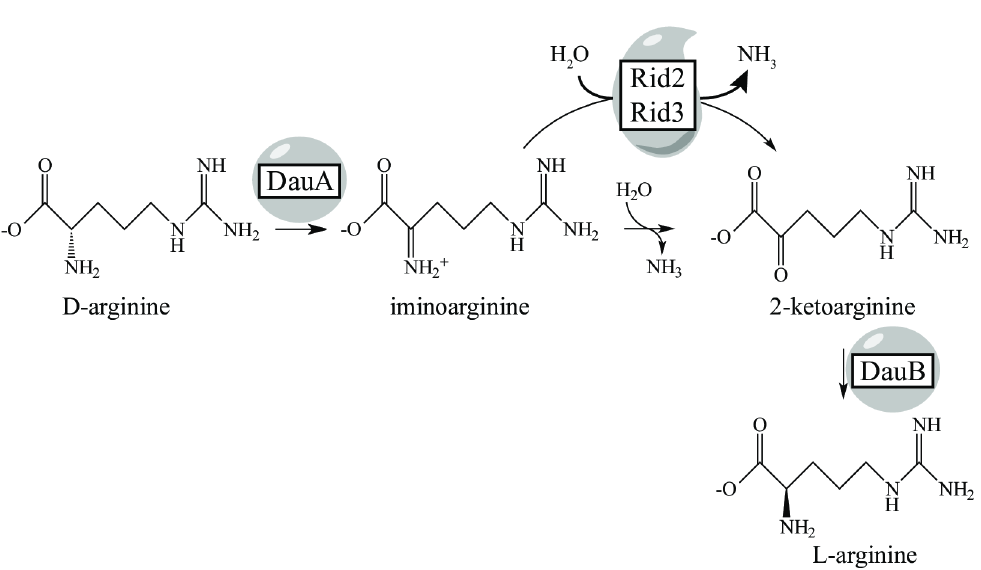
Fig 7. Working model for Rid2 and Rid3 activity. The FAD-dependent D-arginine dehydrogenase generates iminoarginine, which is deaminated by solvent water or by Rid proteins(Rid2 or Rid3), resultingin 2-ketoarginine formation. In Pseudomonas aeruginosa ,DauB converts 2-ketoarginine to L-arginine, enablingthe organism to grow on D-arginineas the sole carbon and nitrogensource